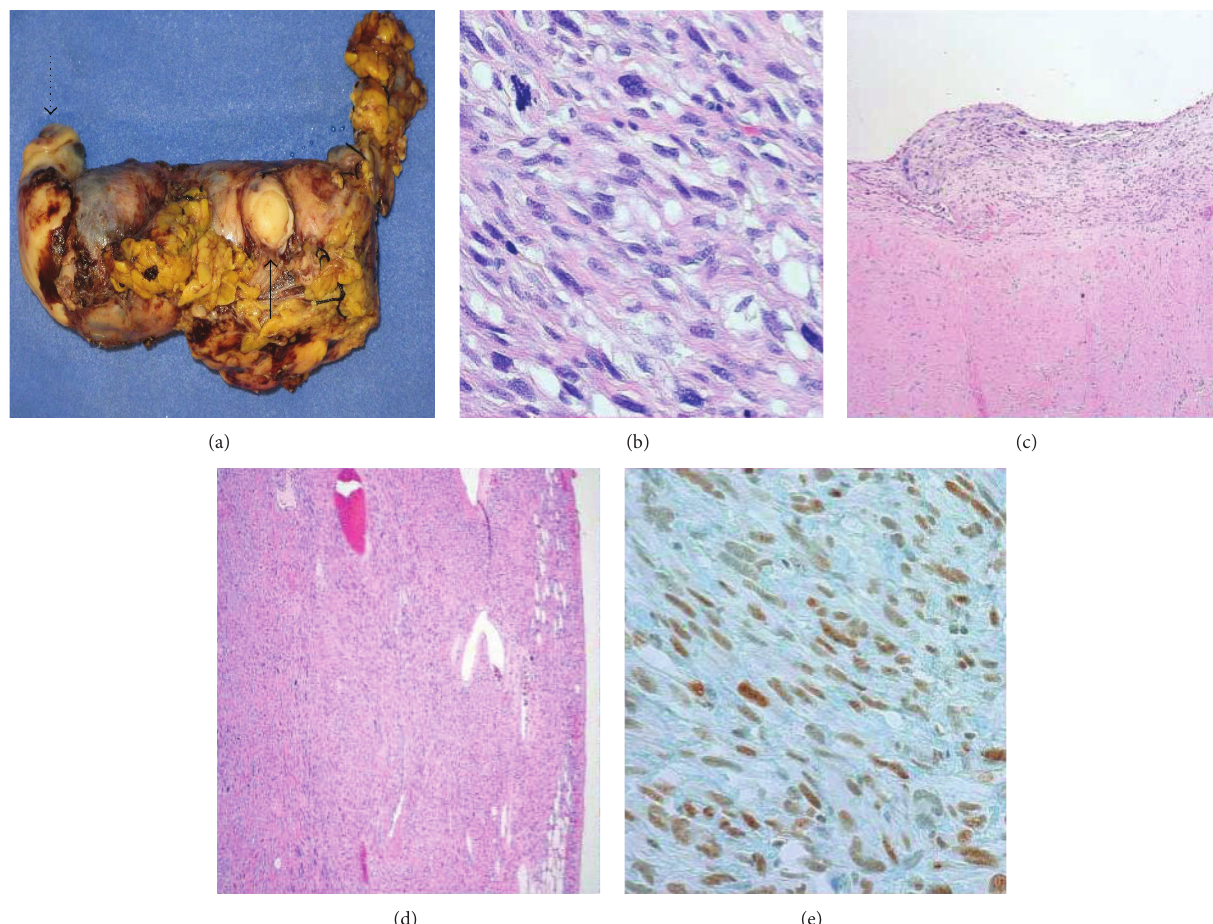
Figure3:(a)Thelumenofinferiorvenacavadistendedbytumor.Dottedarrowspecifiescranialendofspecimen.Solidarrowindicatesostium of renal vein. (b) Spindled tumor cells in fascicles with nuclear pleomorphism and intracytoplasmic vacuoles (H&E 400x). (c) Neoplastic tumor cells lining the intimal surface of the inferior vena cava (H&E 40x). (d) Tumor invading into adjacent adventitial soft tissue (H&E 40x). (e) Tumor with positive staining for Fli-1